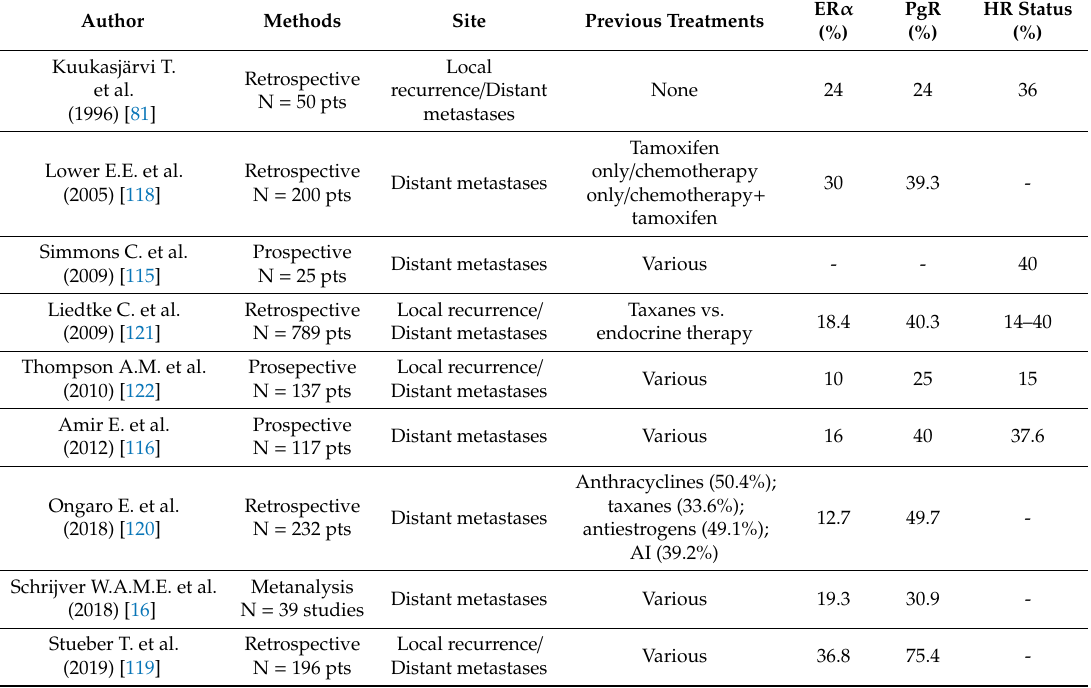
Table 2. Previous studies investigating the discordance rate between primary tumor and local recurrence / distant